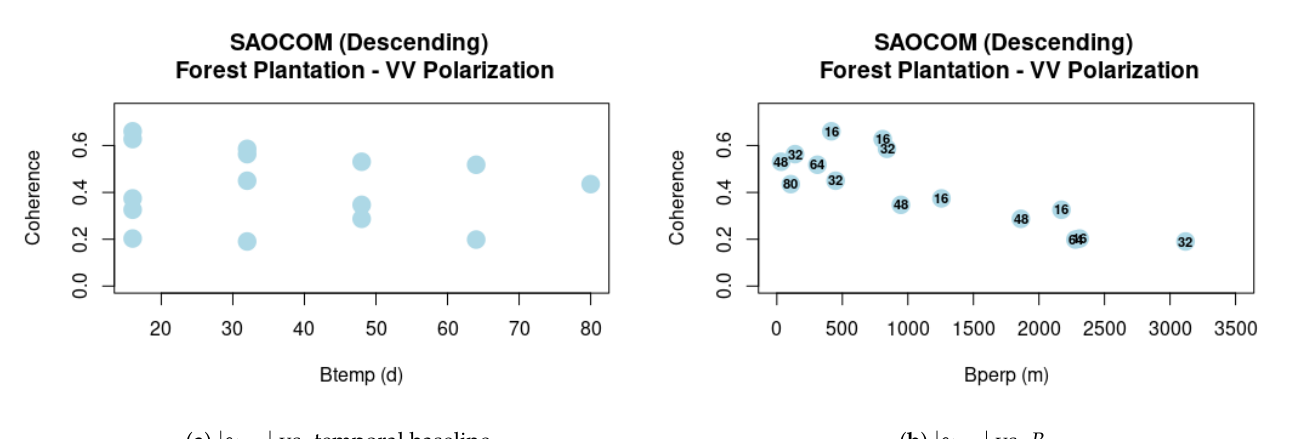
Figure 16. Scatter plot of B ⊥ and B temp vs. | γ | for SAOCOM-1 for region C, Figure 7. The points are labeled with the temporal baseline value to illustrate the effect of B ⊥ .